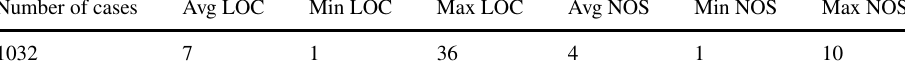
Table 3 Statistics of our